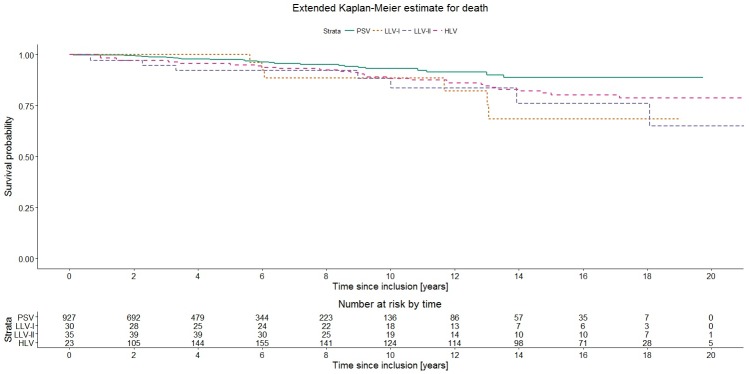
Extended Kaplan-Meier plot for death stratified by viremia category (n = 1015).Abbreviations: PSV–permanently suppressed viremia; LLV-I–low-level viremia 50–199 copies/mL; LLV-II–low-level viremia 200–999 copies/mL; HLV–high-level viremia.